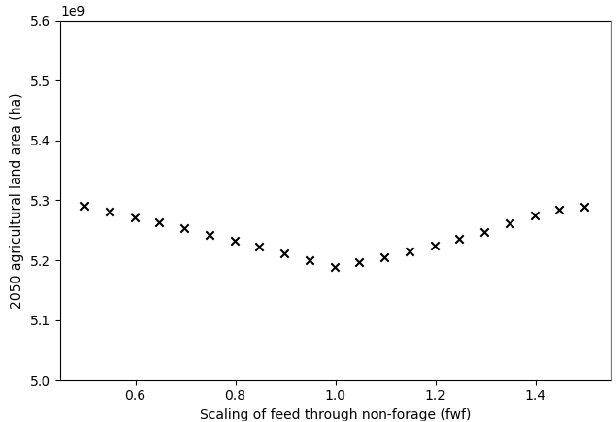
Figure F2. Magnitude of change in pre- and post-global mean scaled effective pasture yield for forced scaling of livestock feed through non-forage